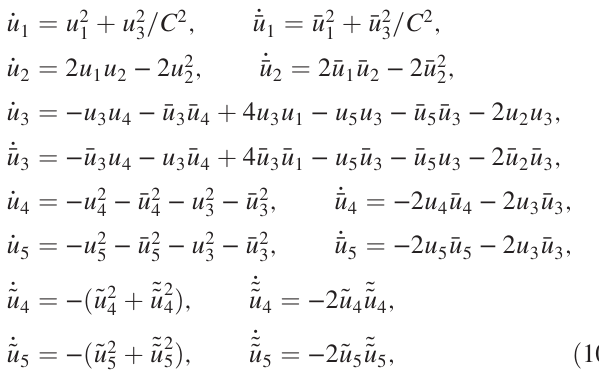
0 , whose ~~ u 4 , ~ u 5 , þ m Þ = e h xy